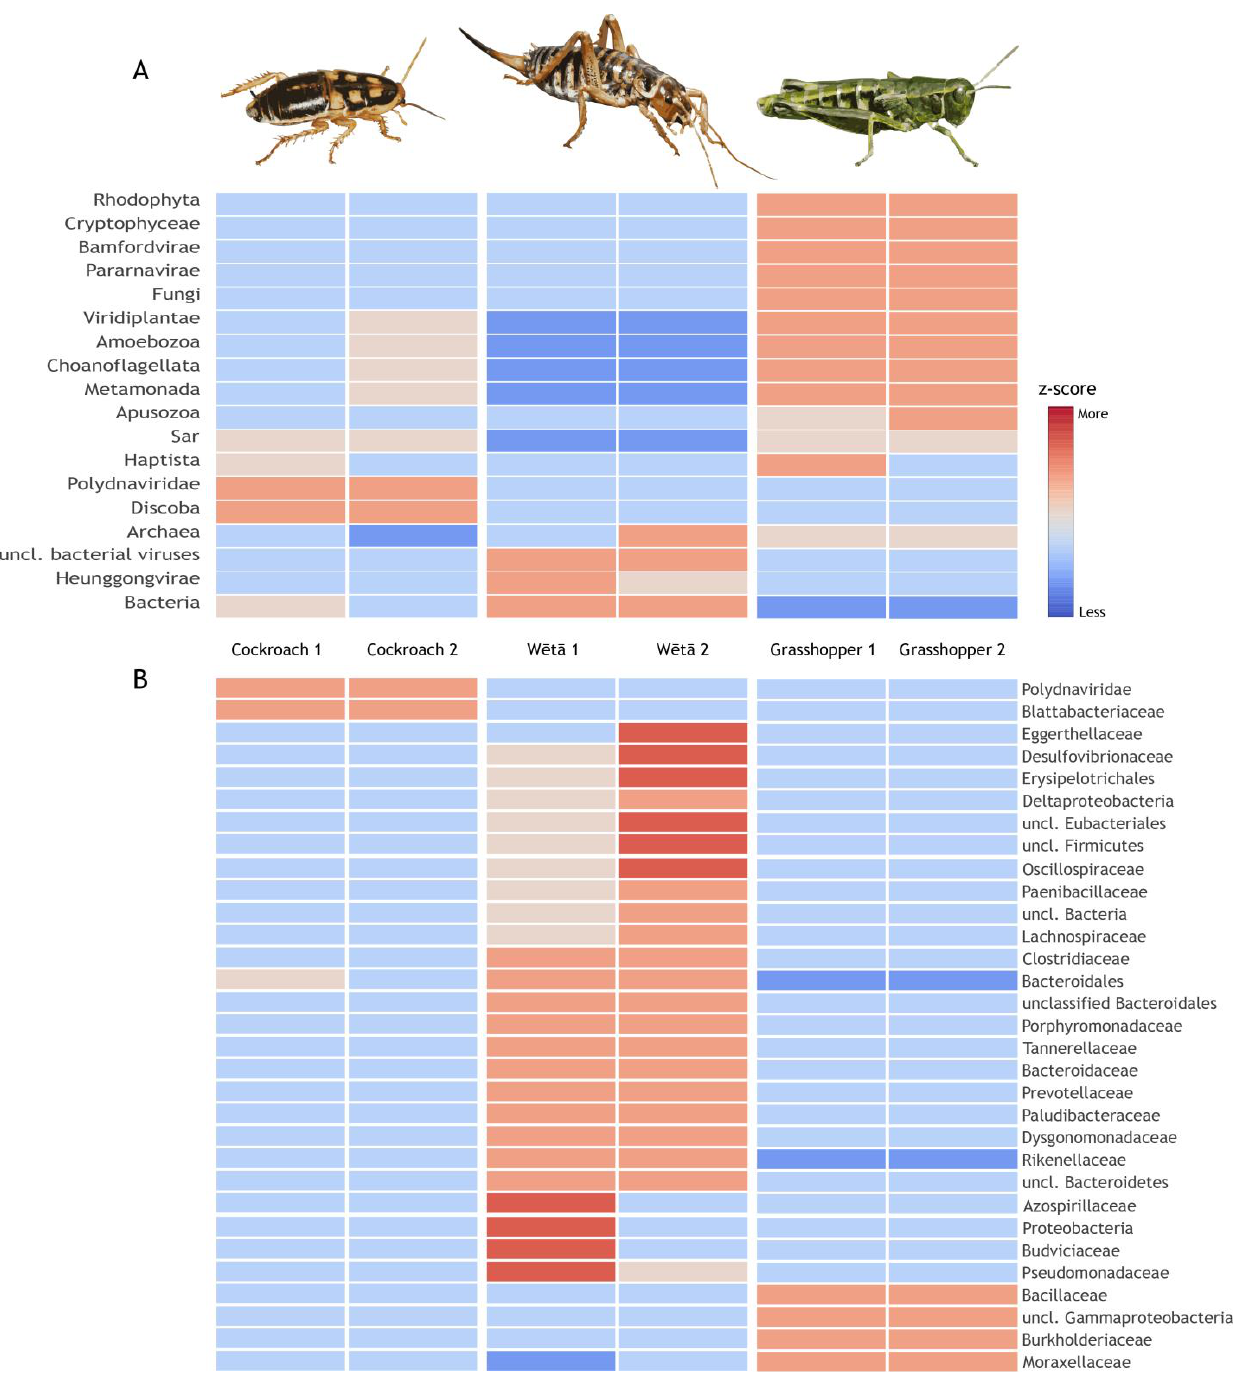
Figure 6. Gut microbiome of six New Zealand freeze-tolerant insects inferred from shotgun DNA sequencing. Heatmaps generated using MEGAN v6.24.1 [105] and visualised as a Z-score for the two samples from cockroaches ( Celatoblatta quinquemaculata ), wētā ( Hemideina maori ), and grasshoppers ( Sigaus australis ) from Central Otago. Data are clustered by sample composition similarity (above) and proportions of the data (right) showing all assigned nodes. The six samples were analysed using the Kaiju webserver (using the nr-euk 2021_03 database), downloaded and processed with a custom Perl script. Results are ( A ) visualised at the taxonomic level of kingdom with only data above a normalised cut-off of 1 read per million sequences shown, and ( B ) visualised at the taxonomic level of family with only data above a normalised cut-off of 100 reads per million sequences shown.